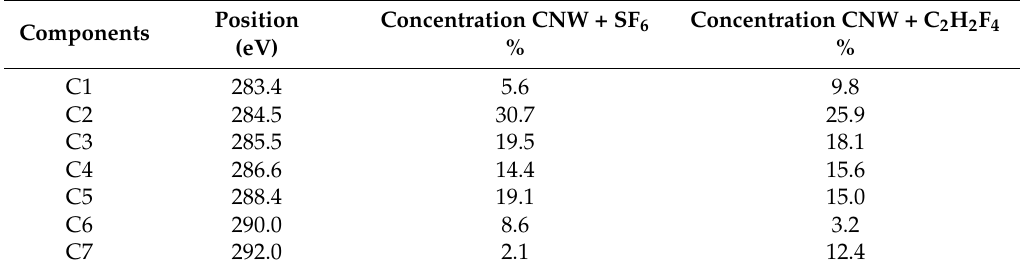
Table 2. Positions and concentration of C1s components for CNW exposed to C 2 H 2 F 4 and SF 6 plasma, respectively.